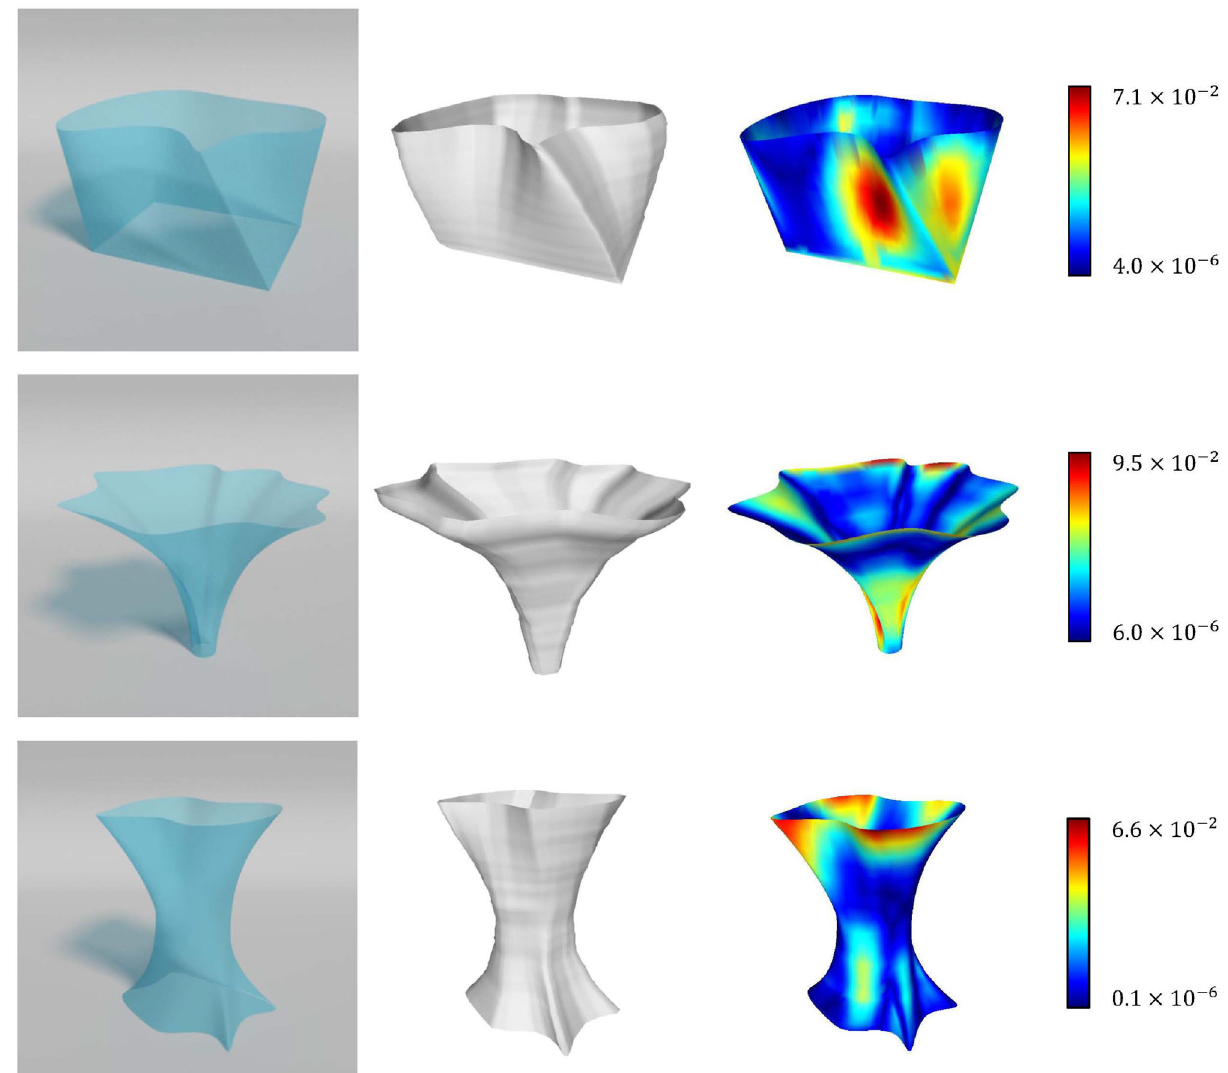
Fig. 9 Quantitative evaluation of our modeling results. Left: rendered synthetic images of the ground truth shapes. Middle: reconstructed shapes using our method. Right: visualization of the geometric errors between the